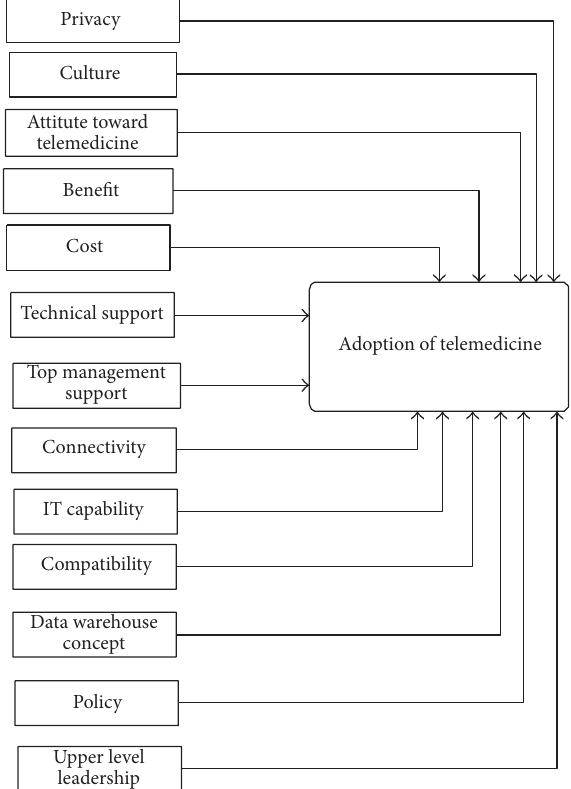
Figure 1: Framework of willingness to adopt telemedicine in